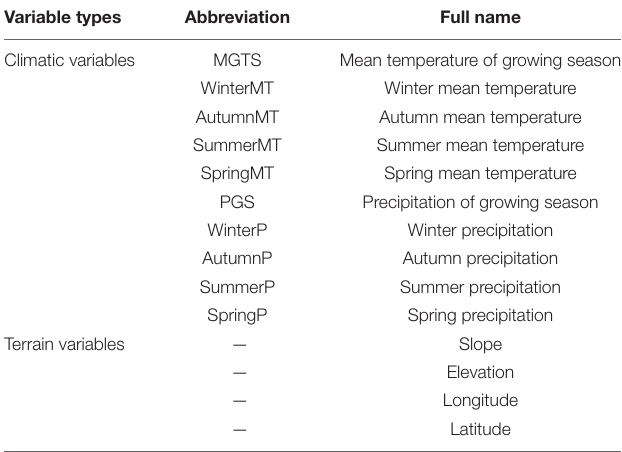
TABLE 2 | Variables used for the impact factors analysis.